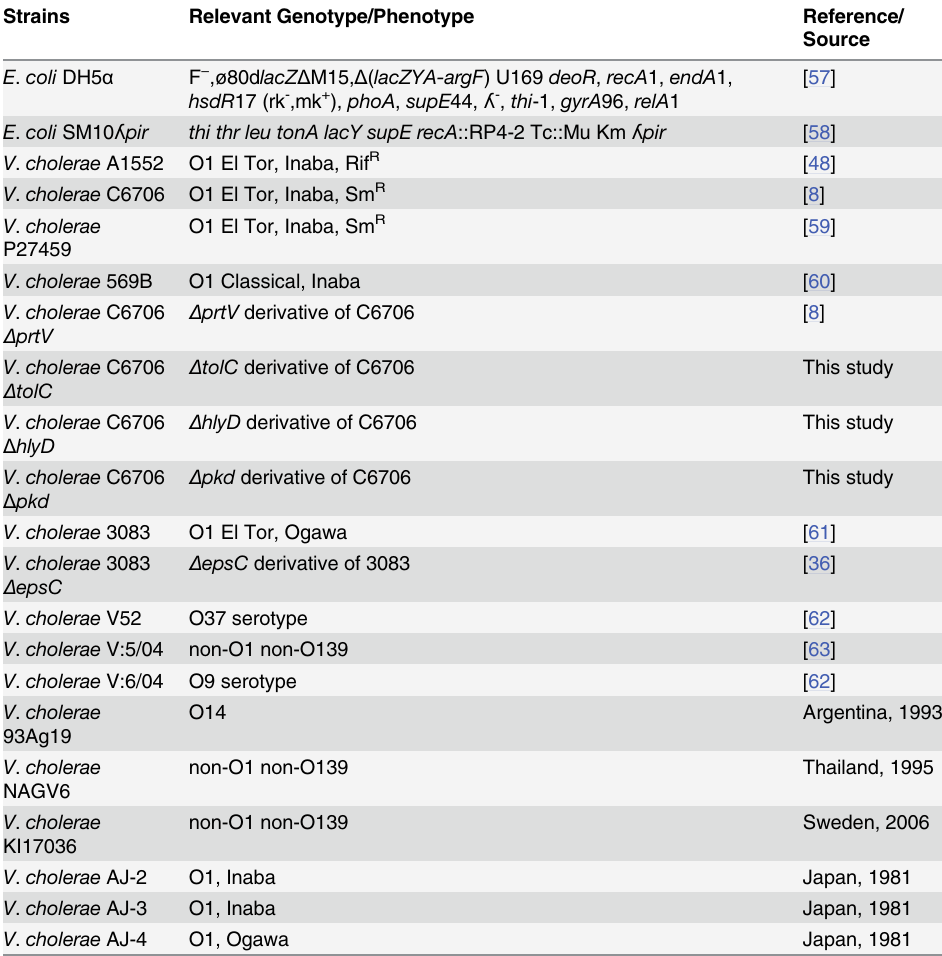
Table 1. Bacterial strains used in this